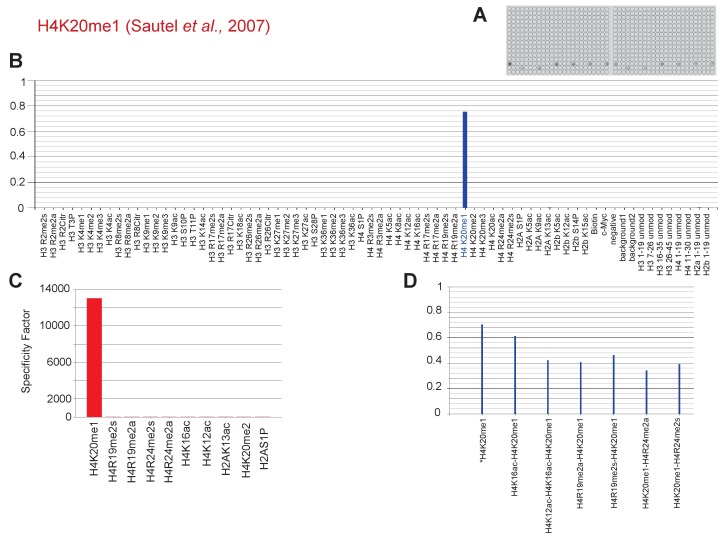
Specific binding ofH4K20me1-directed antibody to H4K20me1-containing peptides in vitro.(a) A 59 PTM-containing MODified Histone Peptide Array (from Activemotif) was incubated with H4K20me1-directed antibody (1/3000; described by Sautel et al. [2007]) and (b–d) the signals were analyzed according to the manufacturer's instructions (see Materials and methods).